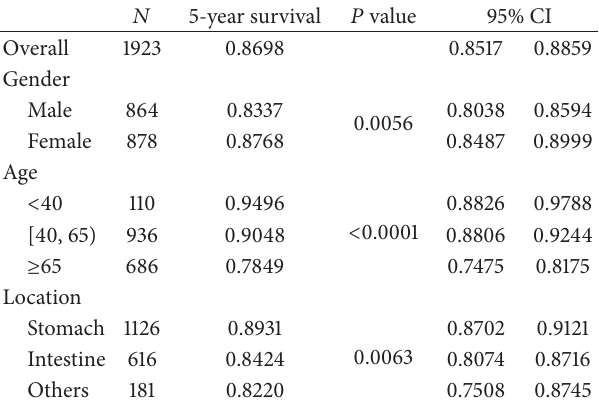
Table 3: 5-year overall survival and 95% CI for GISTs between 2001 and 2010, calculated with Kaplan-Meier method, and the log-rank